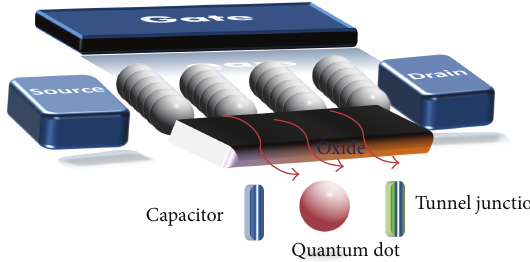
- 𝑉 and (b) 𝐼 3 - 𝑉 . D GS D GS